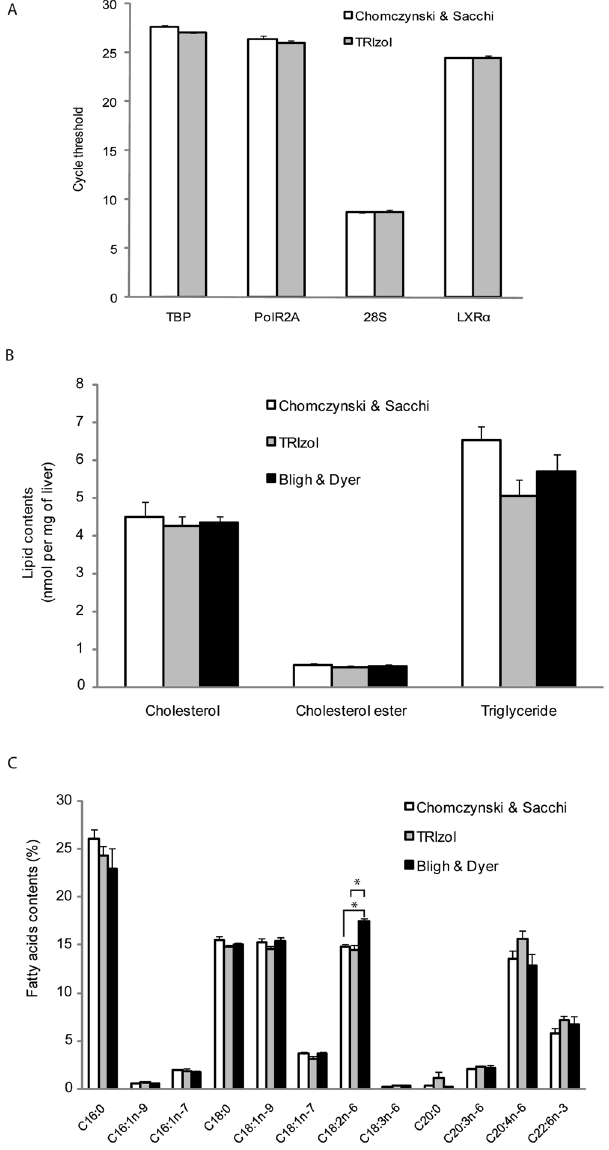
Figure 1. Commercially available Trizol can be used to extract mRNA, total lipids, and total fatty acids from mouse liver samples. ( A ) Commercially available Trizol was compared to the Chomczynski & Sacchi method for mRNA extraction and ( B , C ) to Bligh & Dyer for lipid extraction. RNAs were analyzed by qPCR and lipids by gas chromatography. Data are presented as means ± s.e.m. * P < 0.05 compared to Bligh and Dyer, t-test, n = 4 samples per